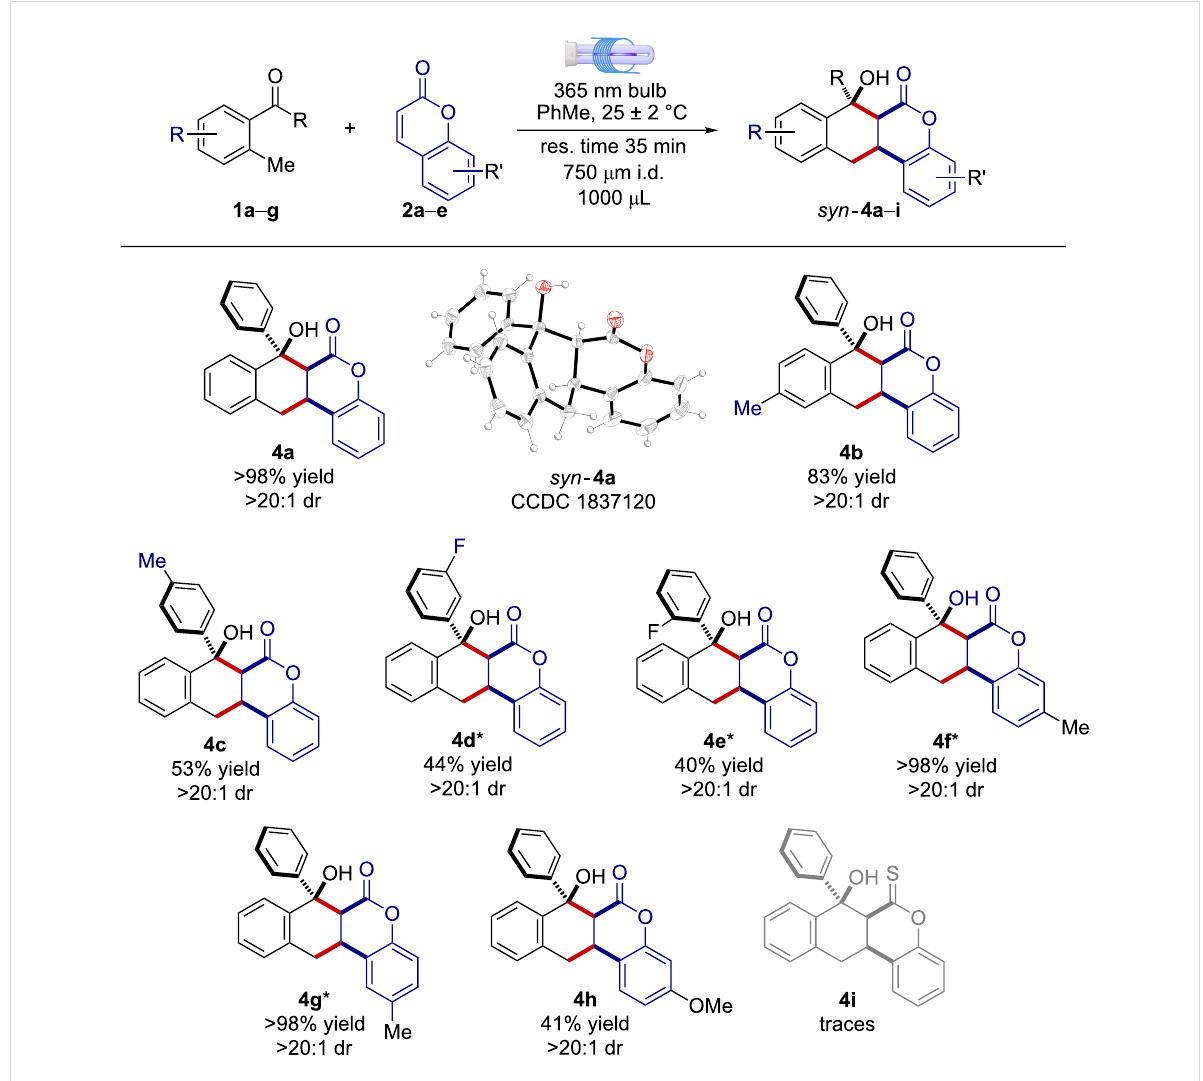
Figure 2: Generality and limits of the light-driven [4 + 2] cyclization reaction between 2-MBP 1a – g and coumarins 2a – c under MFP setup. *Resi- dence time was 60